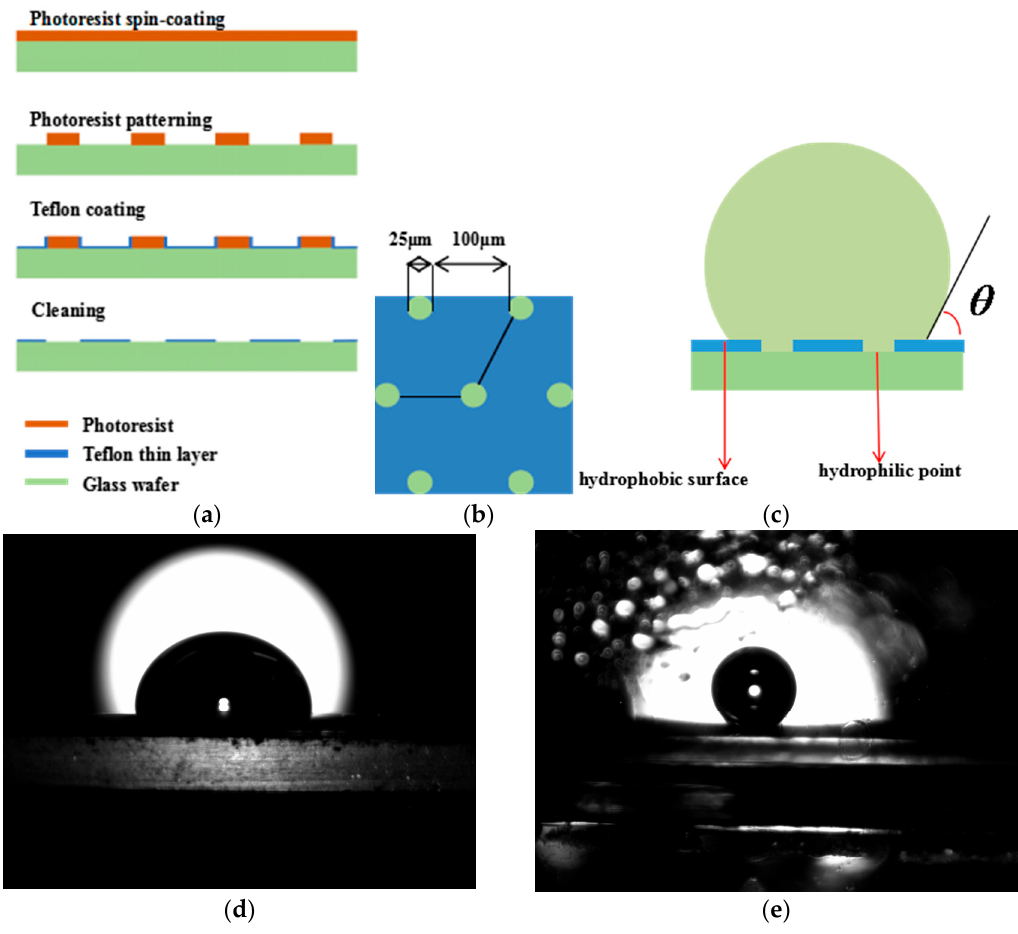
Figure 4. The hybrid substrate. ( a ) The detailed fabrication process flow of the substrate; ( b ) the structure of the substrate; ( c ) the microdroplets on the substrate; ( d ) the side view of the microdroplets on the substrate, in air; ( e ) the side view of the microdroplets covered by oil.